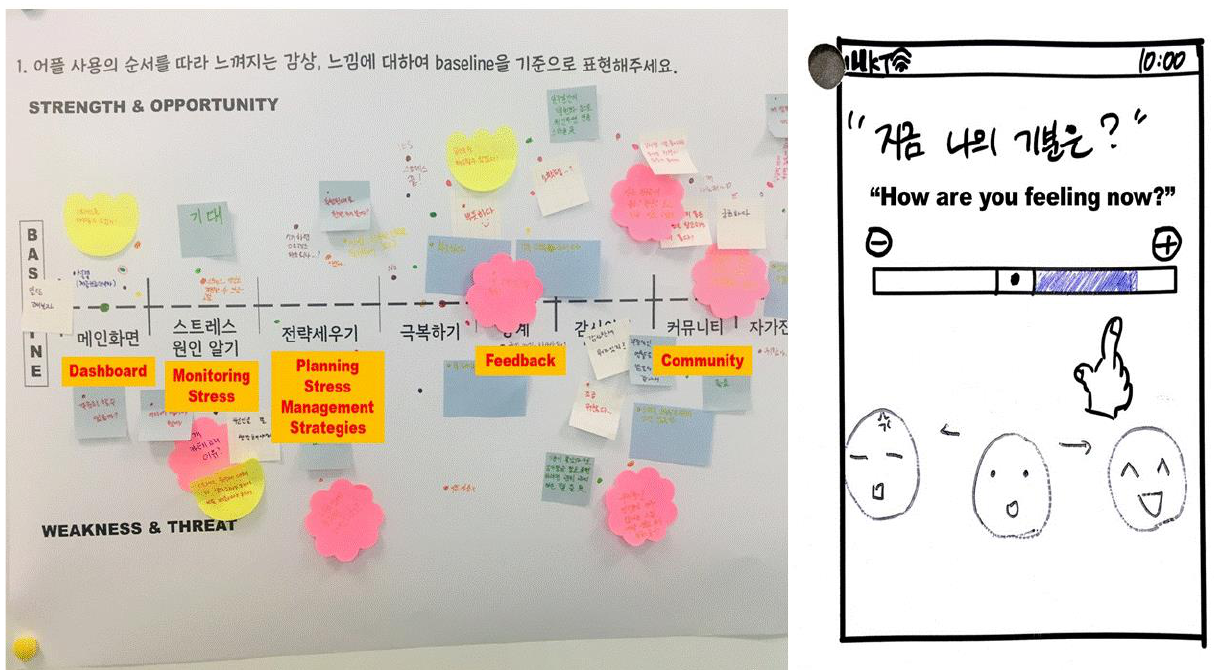
Figure 1. Design cards and journey maps in co-design workshops.